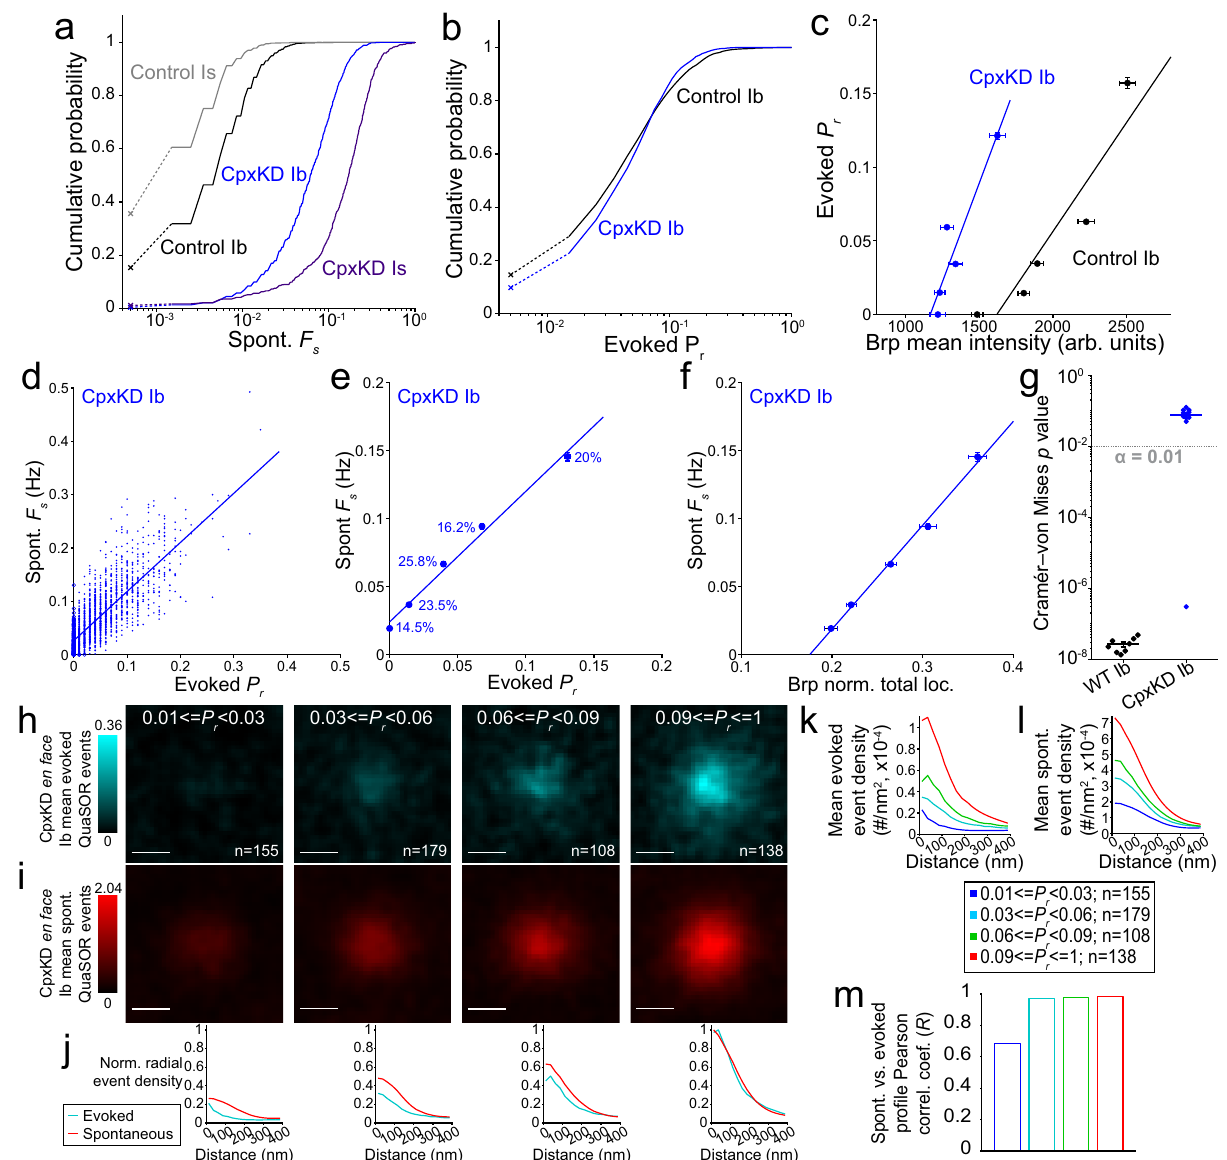
Fig. 7 Cpx knockdown enhances dependence of evoked transmission on Brp and eliminates mismatch between spontaneous and evoked transmission. a CpxKD increases F s in Ib and Is. F s distributions for Control (OK6-Gal4, attP40 Empty , SynapGCaMP6f) Ib ( n = 2709 AZs, 7 NMJs), Control Is ( n = 1114 AZs, 7 NMJs), CpxKD Ib ( n = 1547 AZs, 5 NMJs), and CpxKD Is ( n = 697 AZs, 5 NMJs) QuaSOR-Airyscan matched AZs (One-way ANOVA p = 0; Tukey – Kramer post hoc test; Control Ib vs Control Is p = 0.15; CpxKD Ib vs CpxKD Is p = 3.8 × 10 − 9 ; Control Ib vs CpxKD Ib p < 3.8 × 10 − 9 ; Control Is